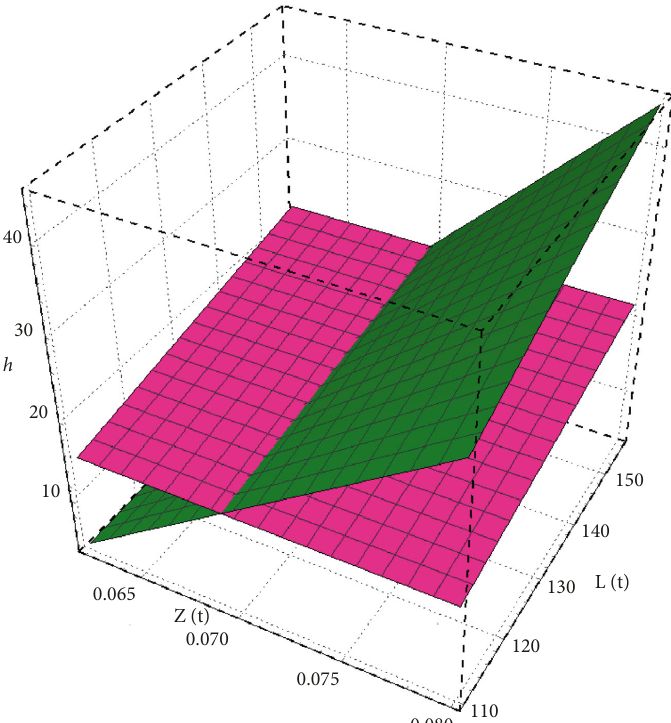
Figure 6: Plot of catch, Z ( t ) and L ( t ) at steady